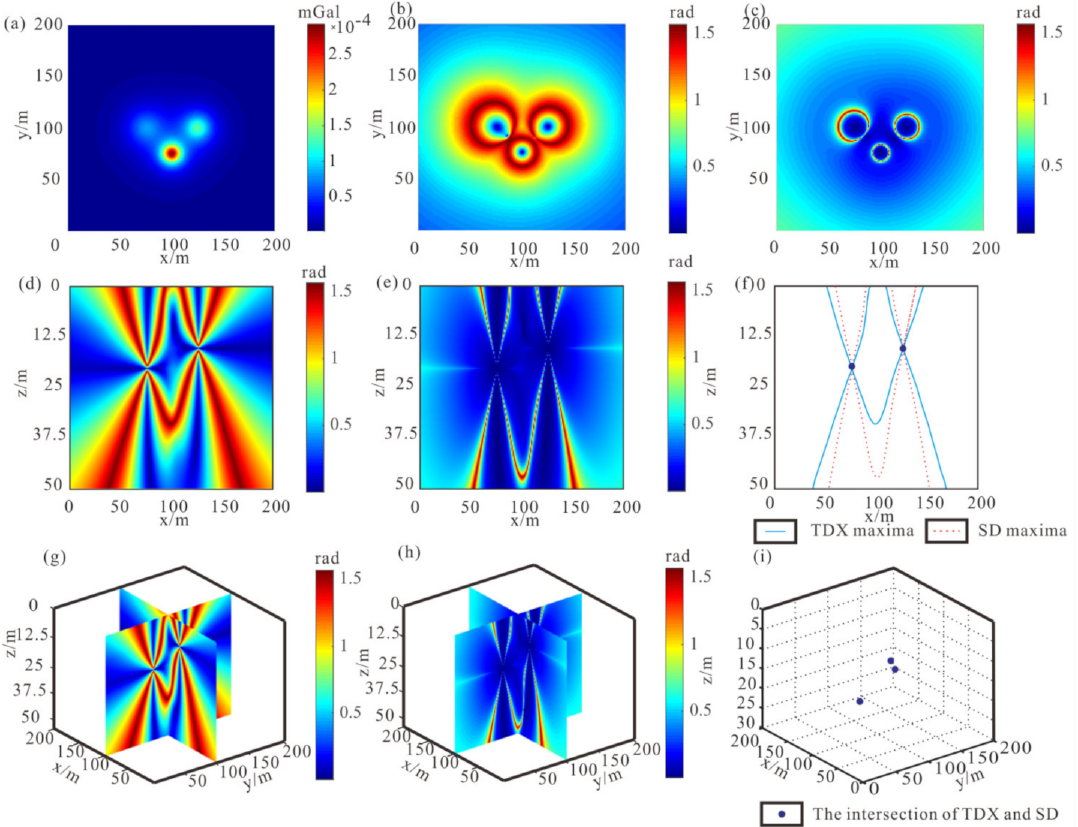
Figure 1. Imaging results of spatial different order derivative method of sphere model: ( a ) Gravity anomaly of sphere model on surface; ( b ) TDX result of gravity anomaly; ( c ) SD result of gravity anomaly; ( d ) TDX result of gravity anomaly in the lower half space; ( e ) SD result of gravity anomaly in the lower half space; ( f ) Slice results of SDD; ( g ) x = 100 m slice of TDX 3D result; ( h ) x = 100 m slice of SD 3D result; ( i ) imaging results of x = 100 m